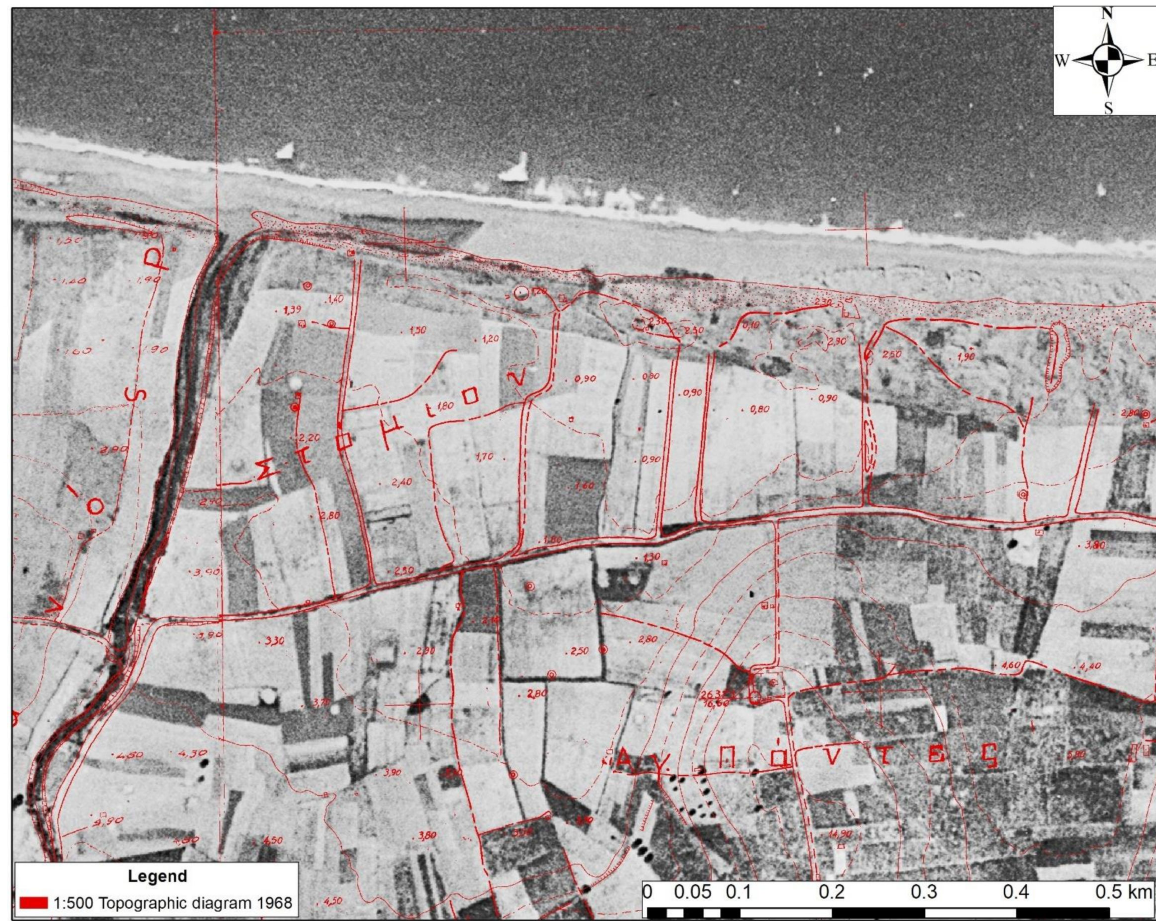
Figure 3. The 1968 aerial photograph and the elevations of the beach area based on the 1968 HMGS 1:5000 topographic